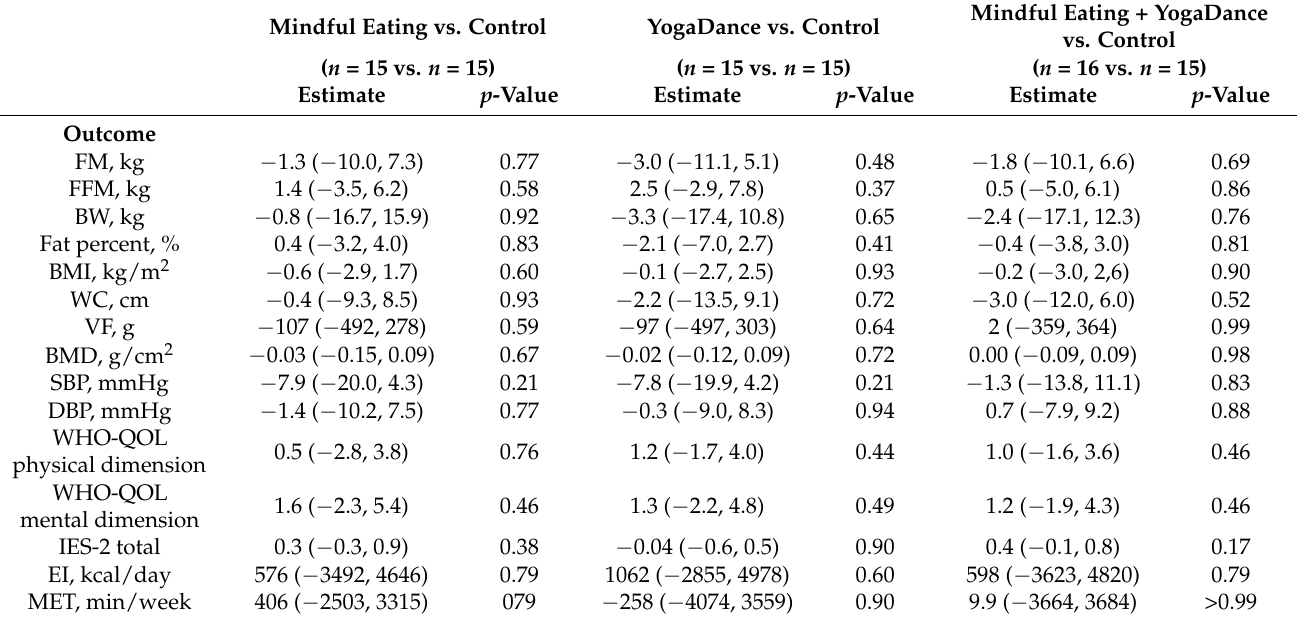
Table 2. Pairwise comparisons of means at the end of the study (after 8 weeks) based on unadjusted intention-to-treat analyses ( n = 61). Mindful Eating vs. Control YogaDance vs. Control